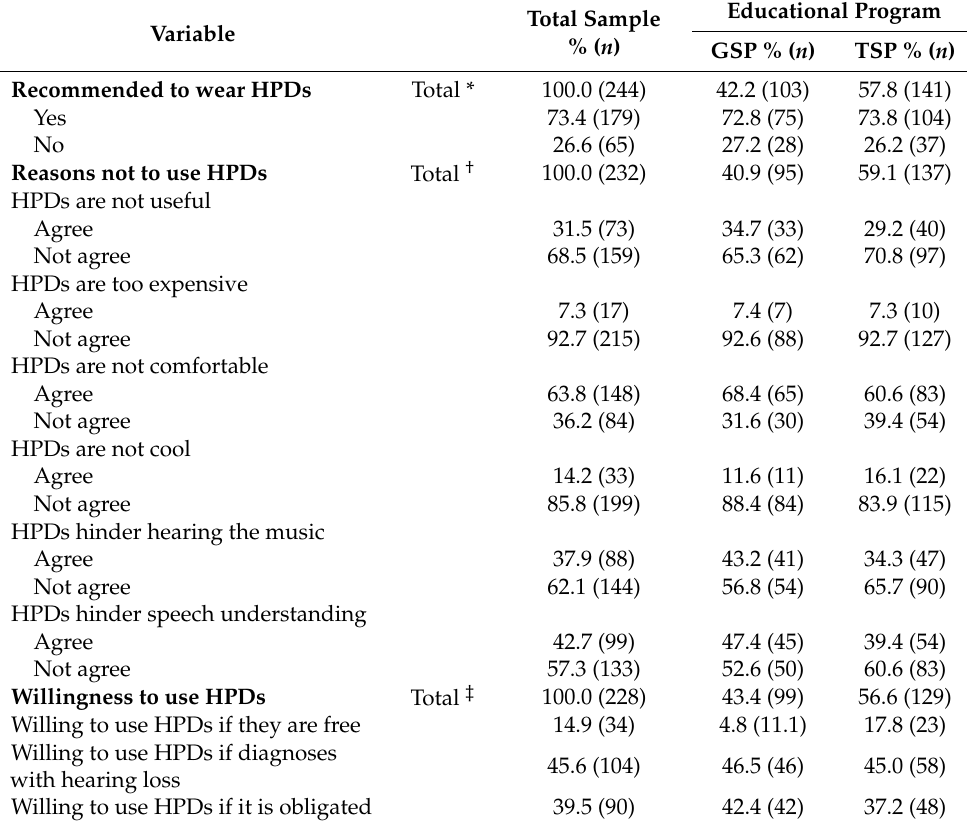
Table 3. Recommendation to wear HPDs, as well as reasons not to use HPDs and the willingness to use HPDs for the total sample as well as distributed for the students from the GSP and